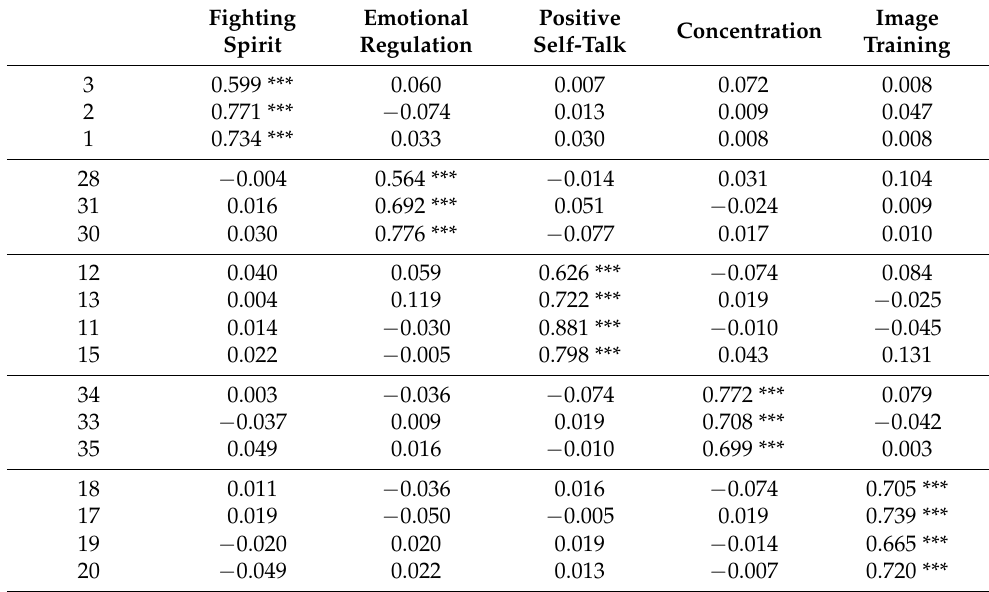
Table 12. Speed Skater Sports Psychological Skills Scale Factor Structure Applying BSEM.